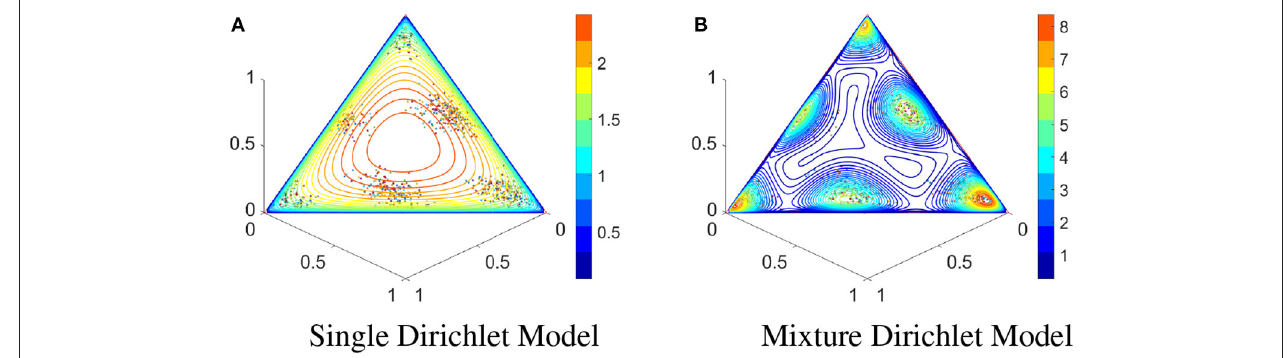
FIGURE 2 | IETs of a binomial point process and contours of Dirichlet models. (A) IETs of simulated binomial point process with 2 events and contours of a fitted single Dirichlet model. (B) Same as (A) except using a Dirichlet mixture model with 6